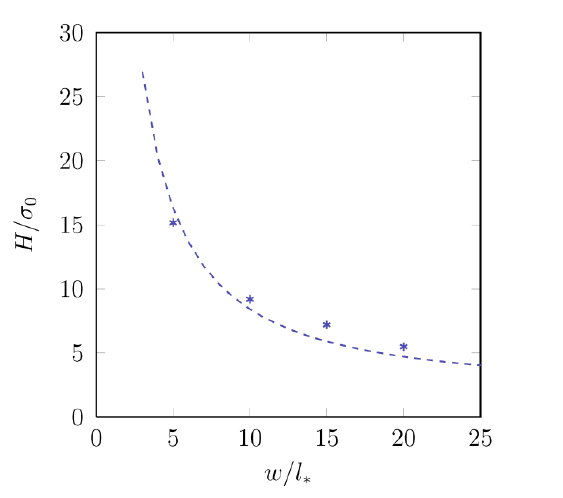
Figure 9. Predicted characteristic hardness against the characteristic length using the viscoplastic model of Fleck2001 SGT [111]. w is half the punch width, H is the hardness, σ 0 is the initial material yield stress and l ∗ is the characteristic length as in Equation